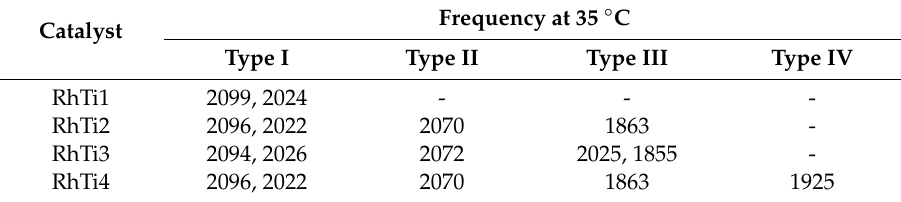
Table 2. Infrared absorption frequencies of CO over supported rhodium catalysts.